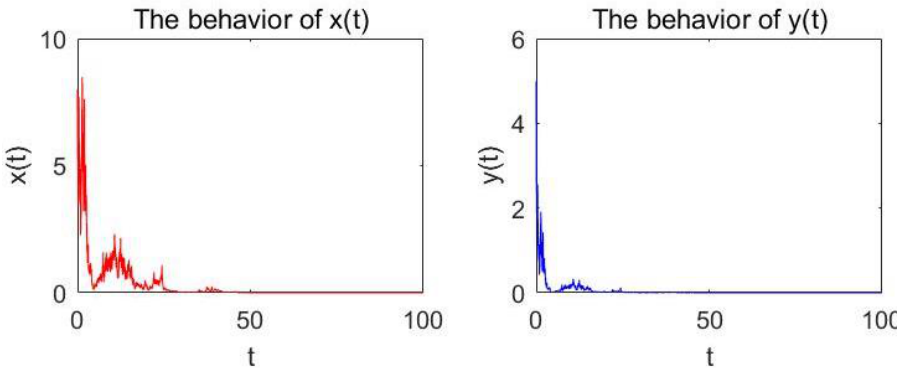
Figure 2. Model (2) population extinction